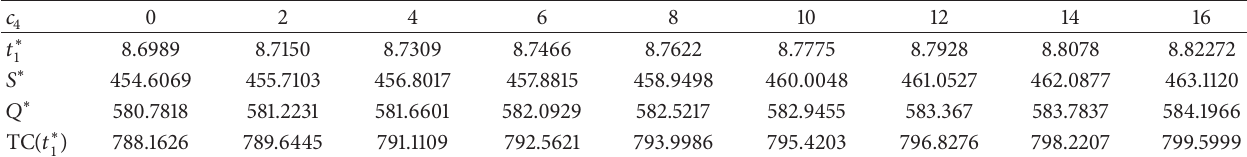
Table 7: The sensitivity of 𝑐 4 for the models in Example